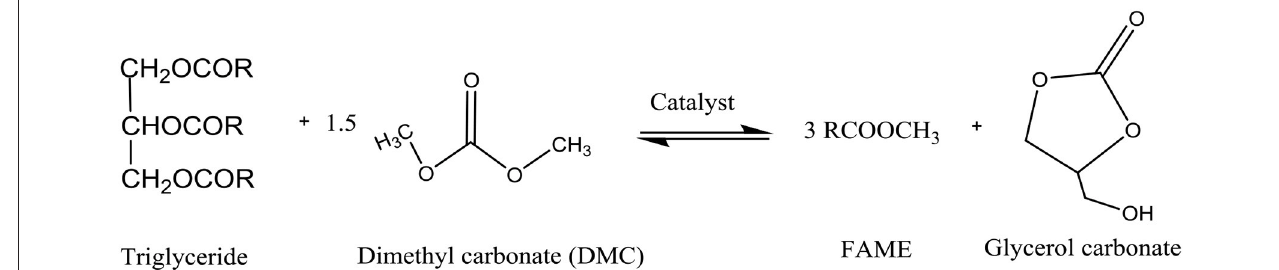
FIGURE 1 | Reaction of triglyceride and